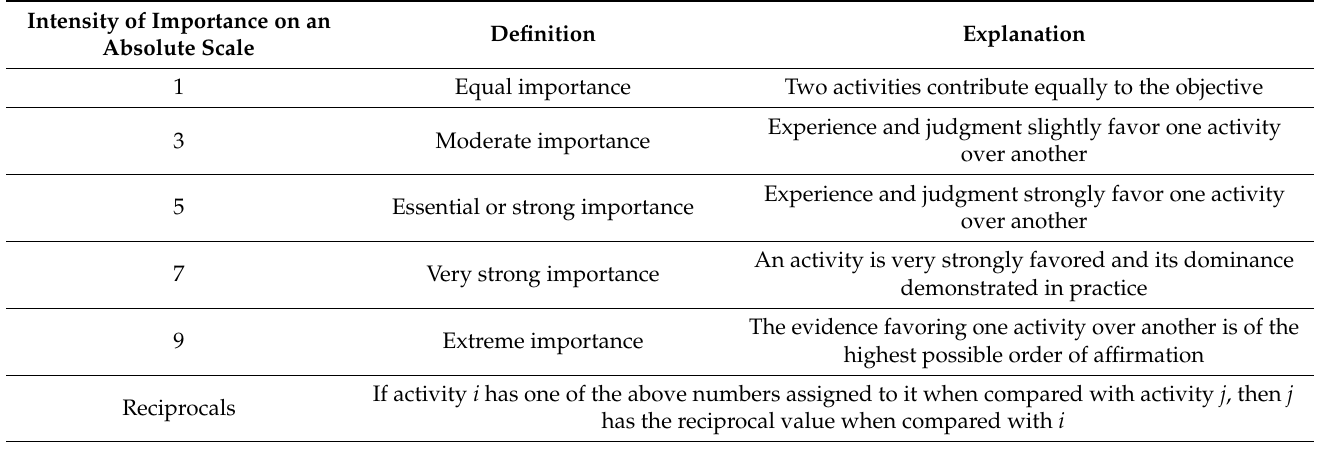
Table 1. The fundamental Saaty